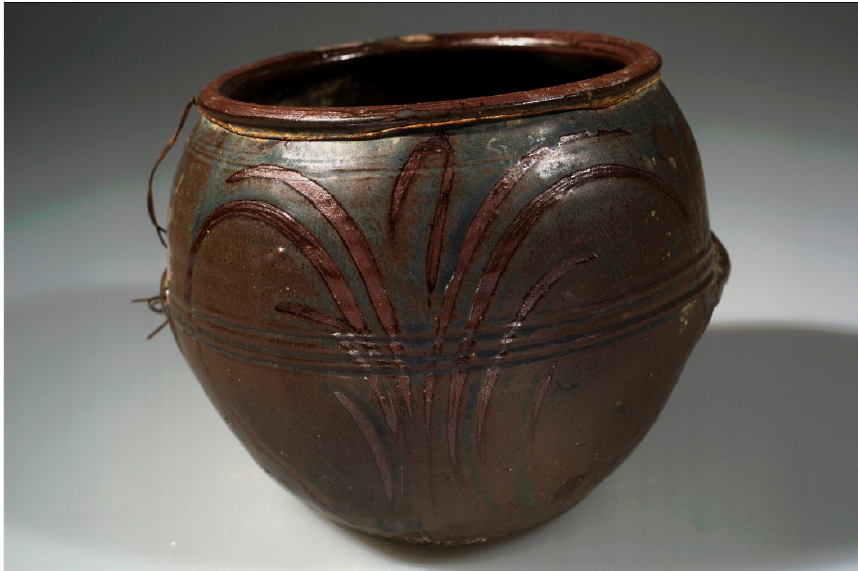
Figure 4. The jar that was once associated with a god. AMNH Anthropology 70.3/5083.